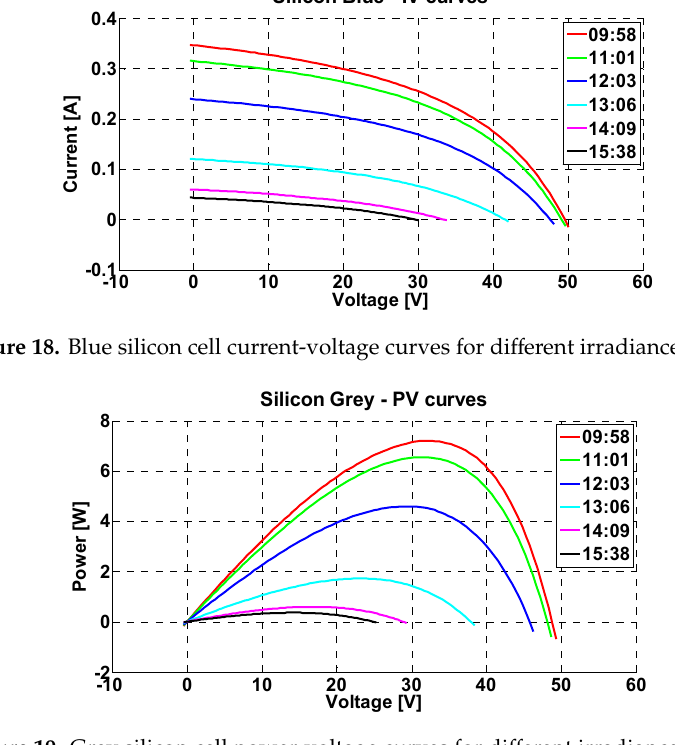
Figure 19. Grey silicon cell power-voltage curves for different irradiance values.